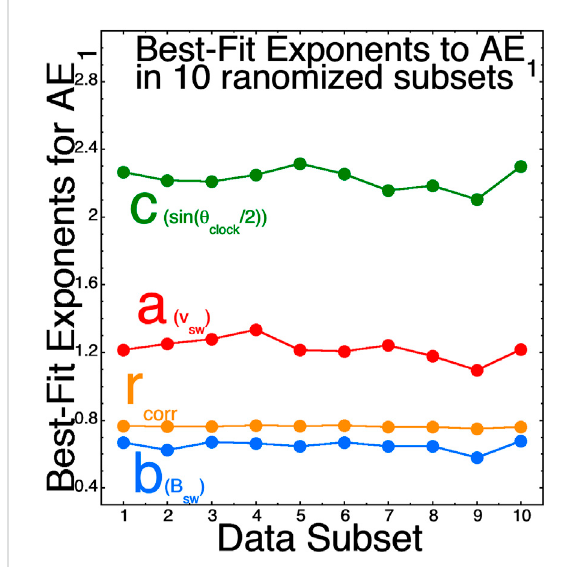
FIGURE 6 The best- fi t (A) (red), (B) (blue), and (C) (green) exponents for AE 1 areplotted whenthe1995 – 2018 OMNI2 dataisrandomized in time and binned into 10 subsets, each of which containing data fromthefullyears1995 – 2018.ThePearson linear correlation coef fi cient for each subset is plotted in orange.